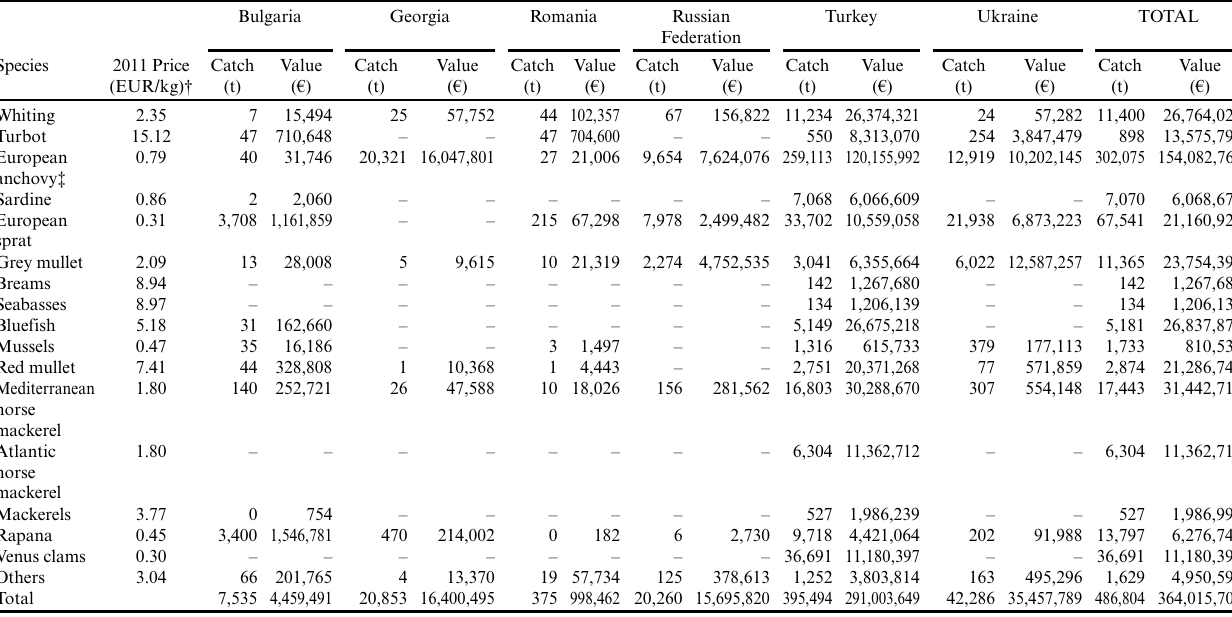
Table 1 . Average catches by species and values of fish in the Black Sea, 2006–2010 (value in 2011 prices). Bulgaria Georgia Romania Russian Turkey Ukraine Federation